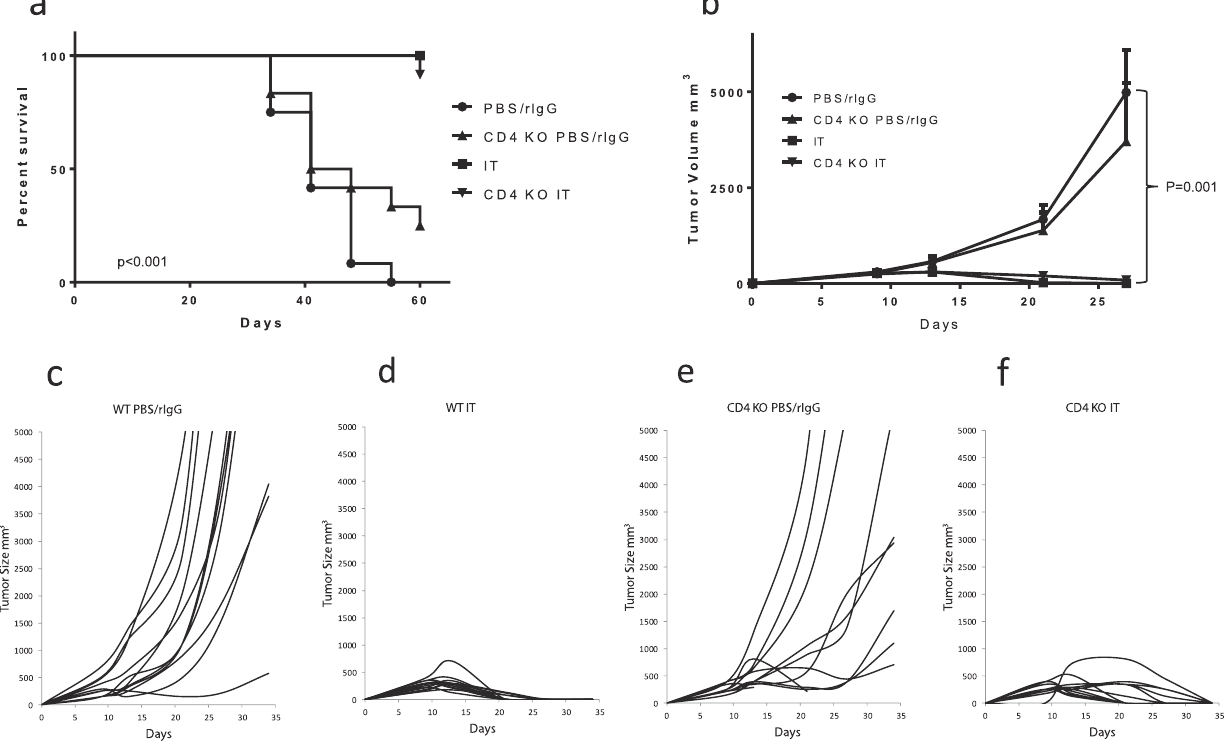
Figure 5. Anti-tumor effects of IT in CD4 knockout mice. 3LL tumor bearing WT or CD4 knockout (B6.129S2-CD4 tm1Mak /J) mice were treated with IT or PBS/rIgG (control) and survival and tumor growth were measured. For in vivo tumor studies one million 3LL cells were administered by s.c. injection into the flank of C57BL/6 mice seven days prior to initiation of therapy. ( a ) Survival. ( b ) Mean tumor volume with SEM. ( c–f ) Growth plots of individual tumors in each group. N=12 mice per group. (* P , .05, ** P , .01, *** P ,